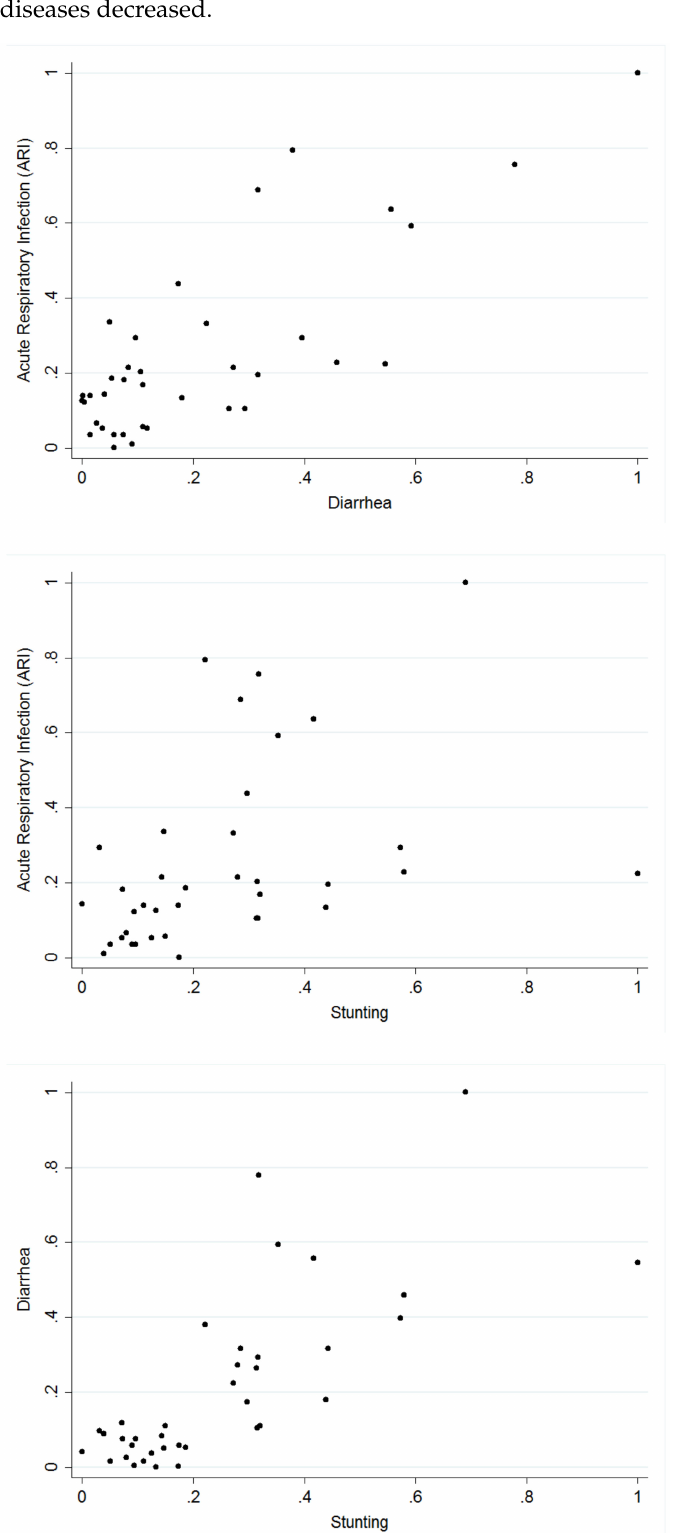
Figure 1. Pairwise scatter plots between the proportions of respiratory infection (ARI), diarrhoea, and stunting based on the 37